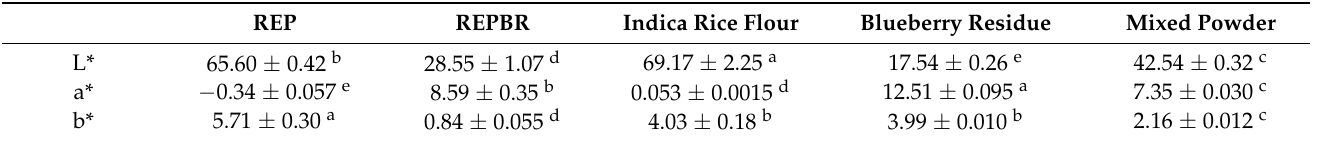
Table 2. Color difference between REP and REPBR.